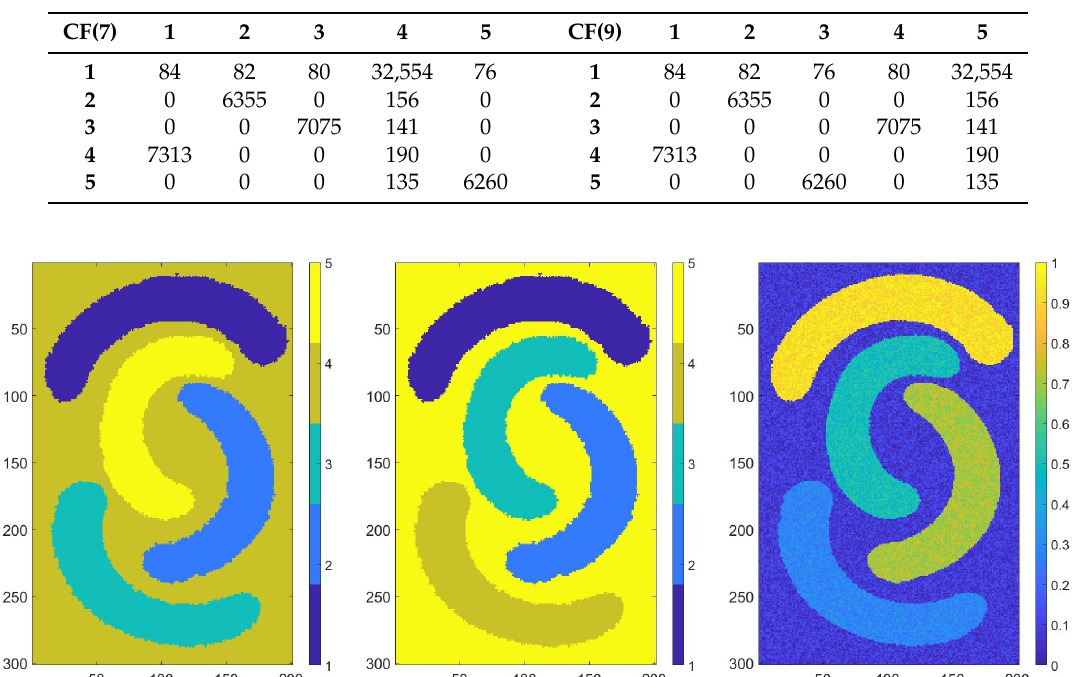
Figure 4. The Voronoi diagram of our dataset classified using seven unsupervised classifiers ( left ) and nine unsupervised classifiers ( center ); the dataset ( right ).